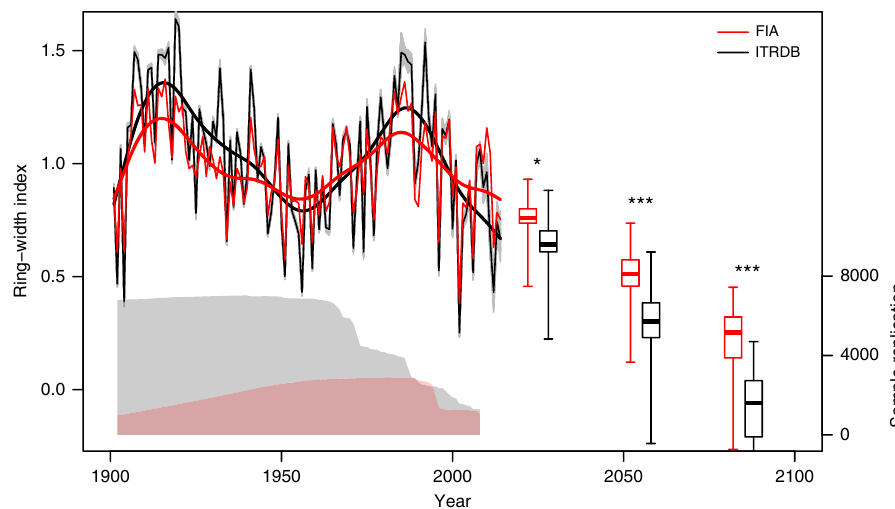
Fig. 5 Regional ring-width index (RWI) chronologies for the U.S. Southwest (all samples south of 38°N) based on the forest inventory sample (FIA, in red) vs. targeted sample (ITRDB, in black). The gray envelopes indicate variability among 100 iterations of randomly resampling available ITRDB ring-width time series to match the sample replication of the FIA chronology. Boxplots show projected mean growth for 2010 – 2039, 2040 – 2069, and 2070 – 2099 under the “ business-as-usual ” scenario RCP8.5 across 15 different Atmosphere-Ocean Global Circulation Models (GCM) from the CMIP5 ensemble. Bold horizontal lines denote the median of the projections, the boxes denote the interquartile range, and whiskers extend to the most extreme future RWI values arising from GCM-projected future climate. Asterisks show the signi fi cance level of differences in projected future tree growth based upon the two datasets (two-sided t test; * p < 0.05; *** p < 0.001). Sample replication, i.e., the total number of ring-width time series, is indicated as counts (right-hand y axis) in gray (ITRDB) and red (FIA) shaded areas below the chronologies (right-hand y